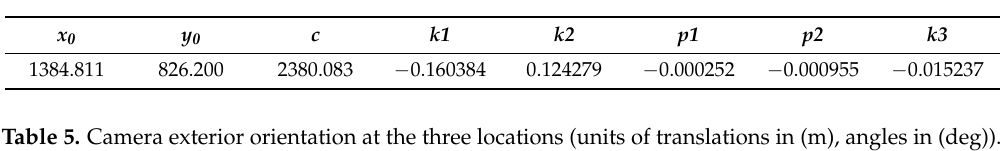
Table 4. Camera interior orientation (units in (pixels)) and distortion coefficients.